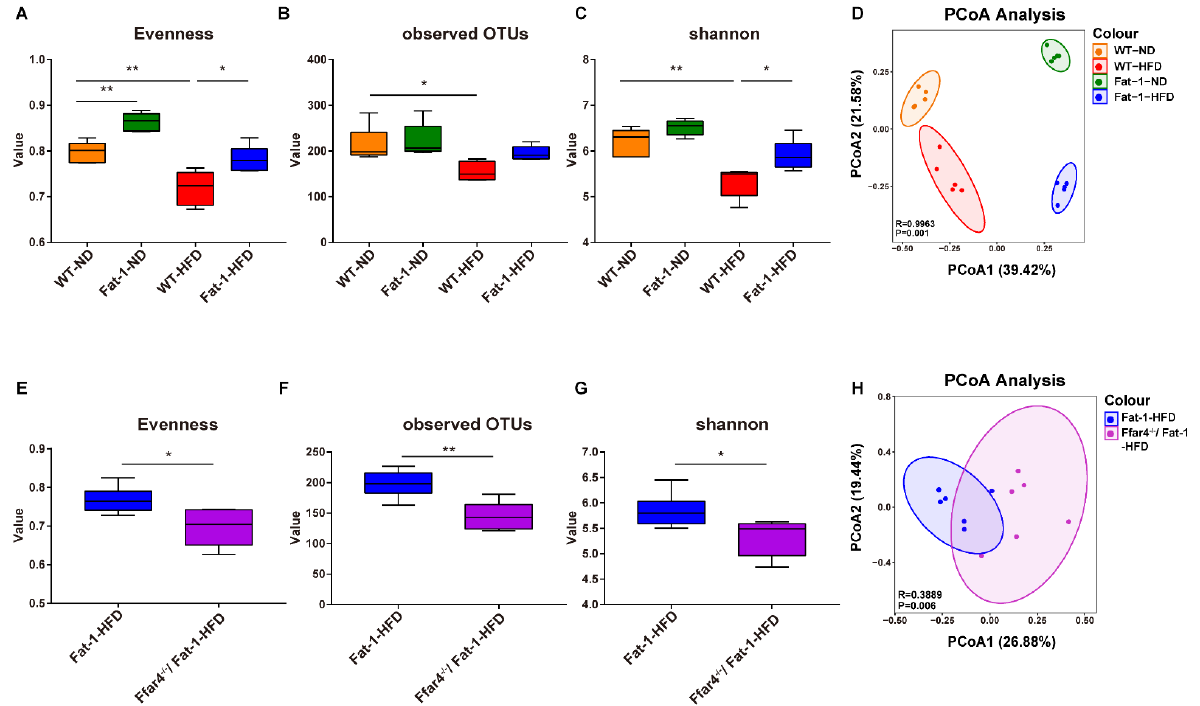
Figure 3. Diversity analysis of gut microbiota among different groups. Alpha diversity of the gut microbiome shown as evenness ( A ), observed OTUs ( B ), and Shannon index ( C ) among the WT-ND, Fat-1-ND, WT-HFD, and Fat-1-HFD groups. ( D ) PCoa plot of beta diversity in four groups (WT-ND, Fat-1-ND, WT-HFD, and Fat-1-HFD group). Alpha diversity of gut microbiome shown as evenness ( E ), observed OTUs ( F ), and Shannon index ( G ) between the Fat-1-HFD and FFAR4 −/− / Fat-1-HFD groups. ( H ) PCoa of beta diversity in two groups (Fat-1-HFD and FFAR4 −/− /Fat-1-HFD). Results are shown as mean ± SD ( n = 5 – 6 for each group). * p < 0.05, ** p < 0.01.